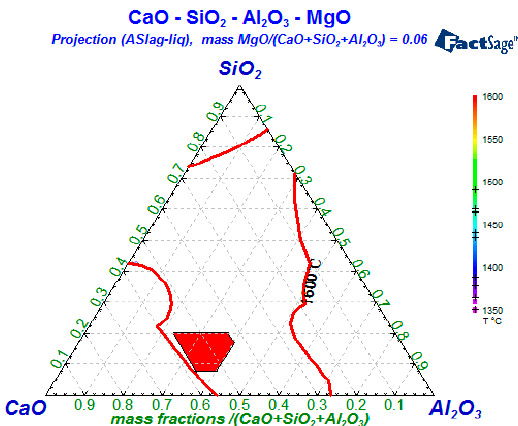
Figure 10. T = 1873 K, quaternary phase diagram of CaO-SiO 2 -Al 2 O 3 -6%MgO slag.